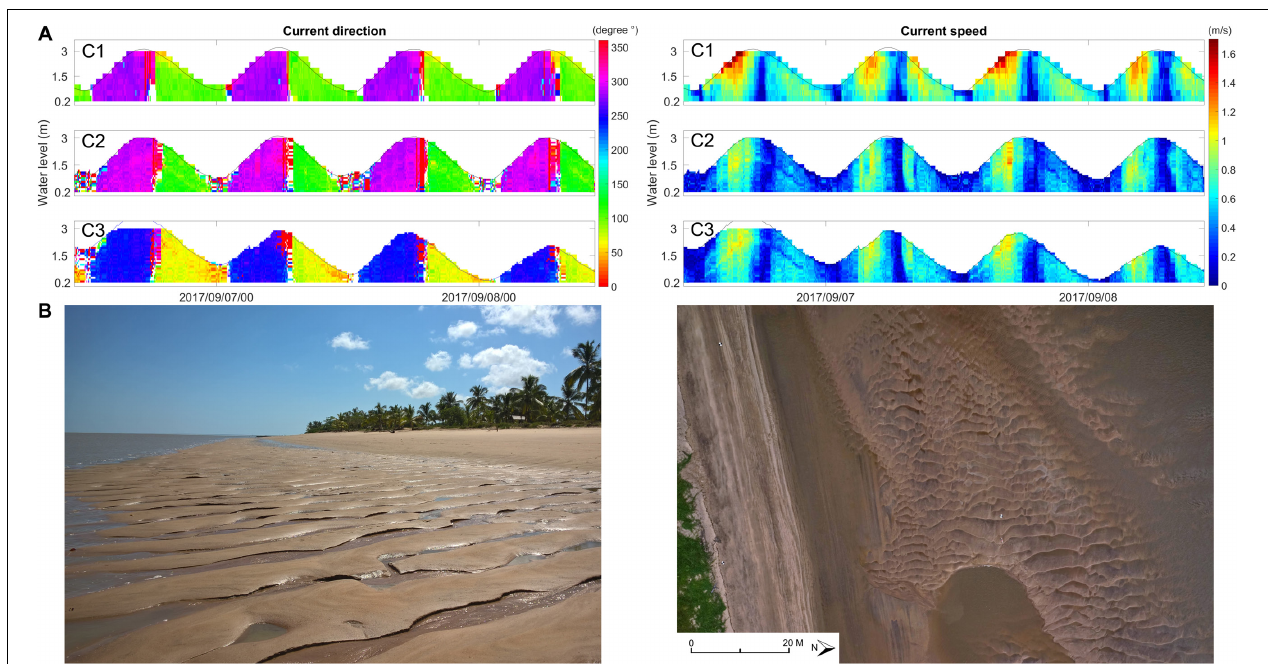
FIGURE 8 | Currents measured near the beach (see Figure 2 ) over several tidal cycles (A) and photographs of bedforms (2D to 3D dunes) on the shoreface adjacent to the beach (B) .